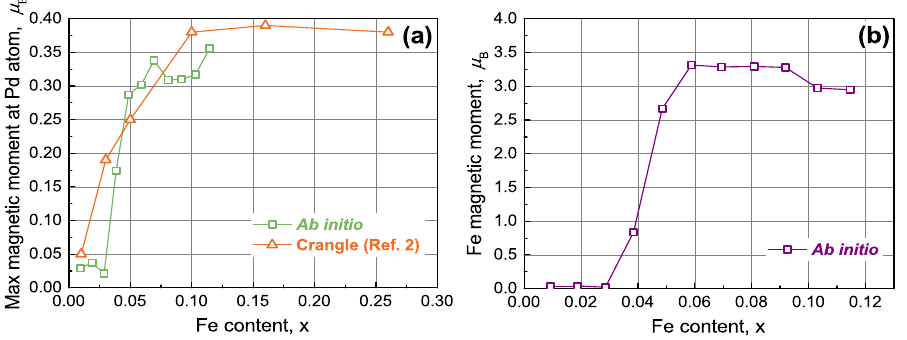
Figure 3. ( a ) Maximal magnetic moment calculated for a Pd atom versus the Fe + atoms content in a 3 × 3 × 3 Pd supercell with uniform impurity distribution (green line with squares) along with the experimental data for the bulk alloy [2] (red line with triangles); ( b ) The calculated average magnetic moment per Fe atom with the uniform impurity